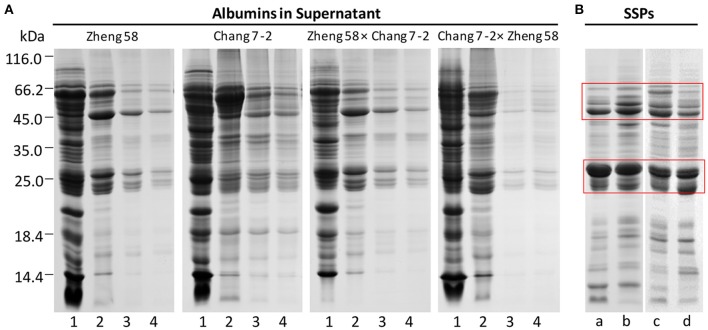
SDS-PAGE of albumins and SSPs in maize embryos. 1–4, representing the times of albumin extraction; a–d, representing Zheng 58, Zheng 58 × Chang 7-2, Chang 7-2, and Chang 7-2 × Zheng 58, respectively; red box, highlighting the regions of enriched SSPs. (A) Removal of albumins by water extraction. (B) Enrichment of SSPs after depletion of albumins.